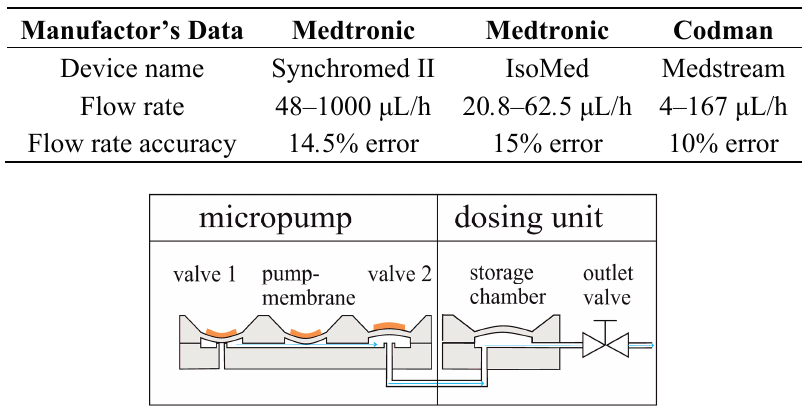
Table 1. Commercial drug infusion pumps for clinical applications [4].